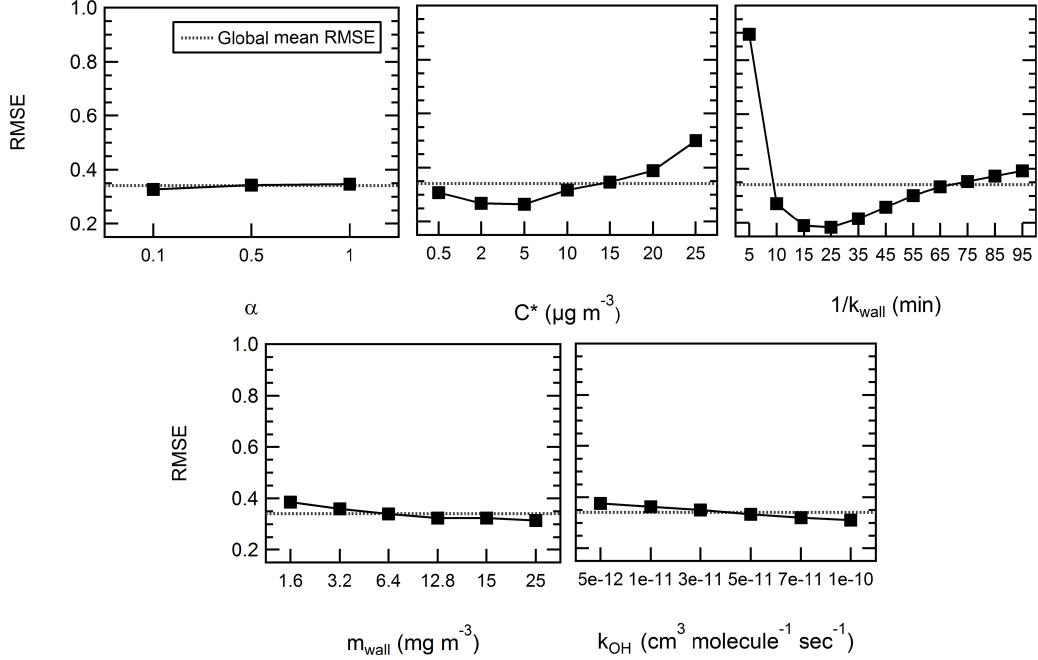
Figure 4. Influence of the factors on the model in the case of levoglucosan – mean effect plots for RMSE.